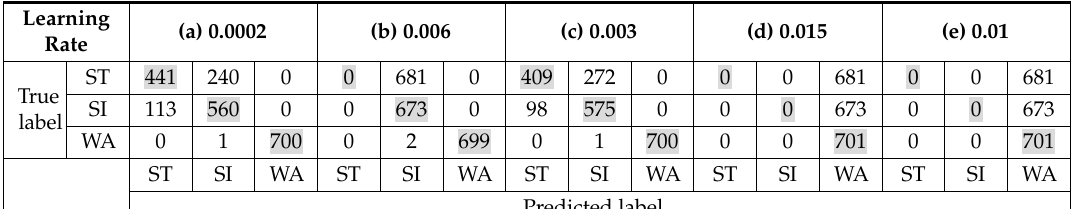
Table 5. Confusion matrices: (OR only)—100-feature vector